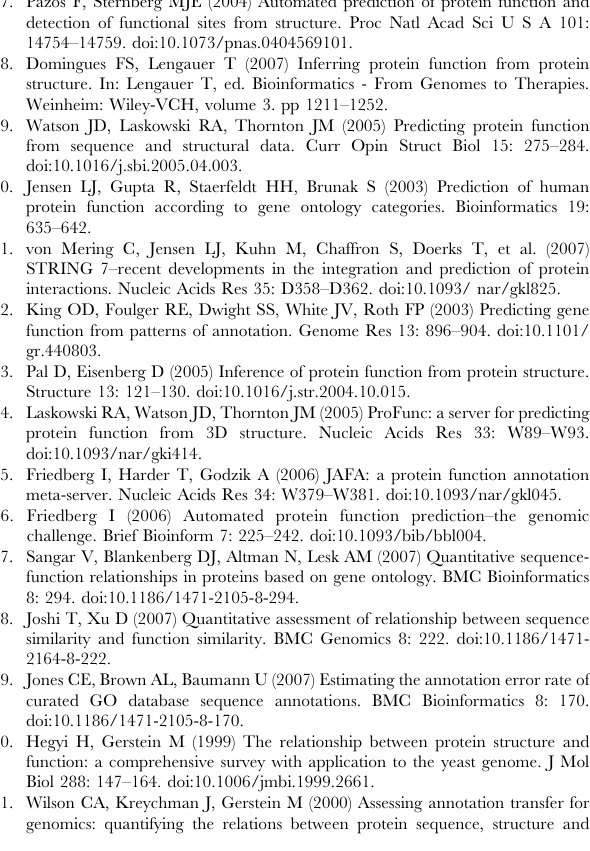
proteins, GO terms are predicted as likely, regardless of their level within the GO hierarchy. This leads to false terms predicted as